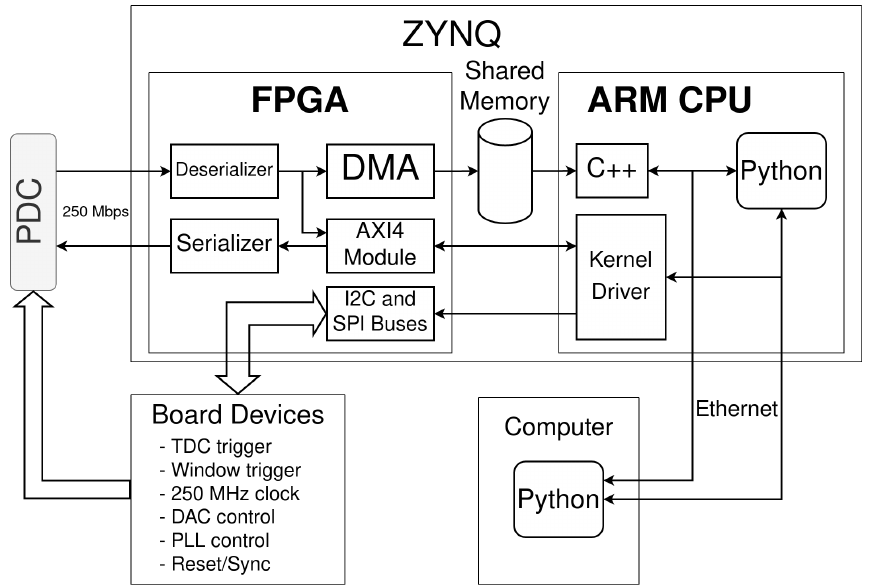
Figure 12. Simplified dataflow diagram for the data acquisition system. The direct memory access (DMA) allows one to send the data directly to memory space for the CPU to process. Python